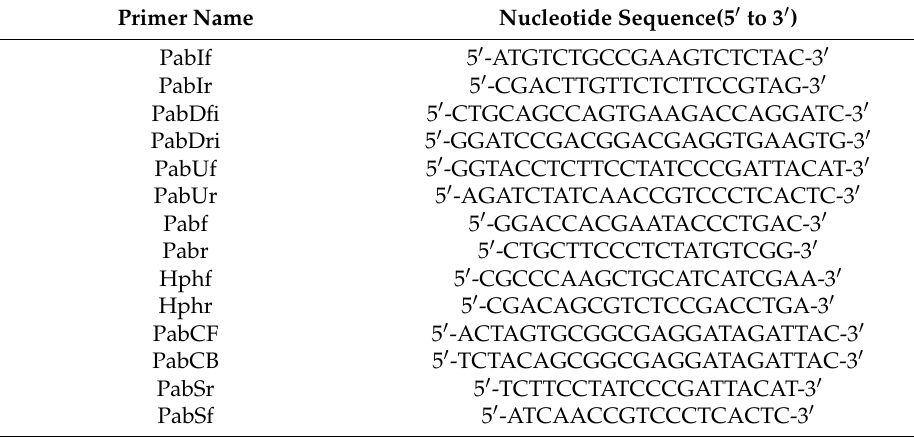
Table 1. Primers used in this